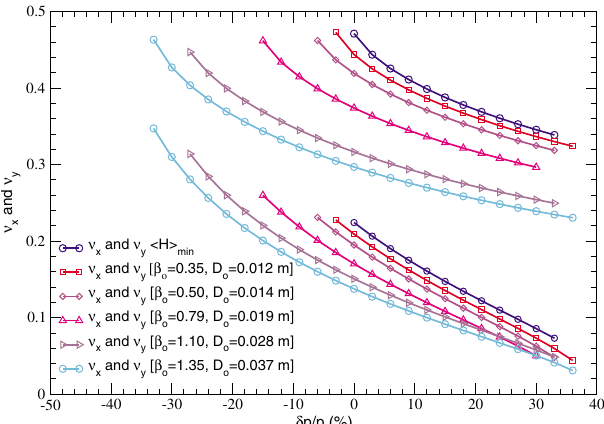
FIG. 9. (Color) Orbit offsets and path length differences vs H . max and x 0